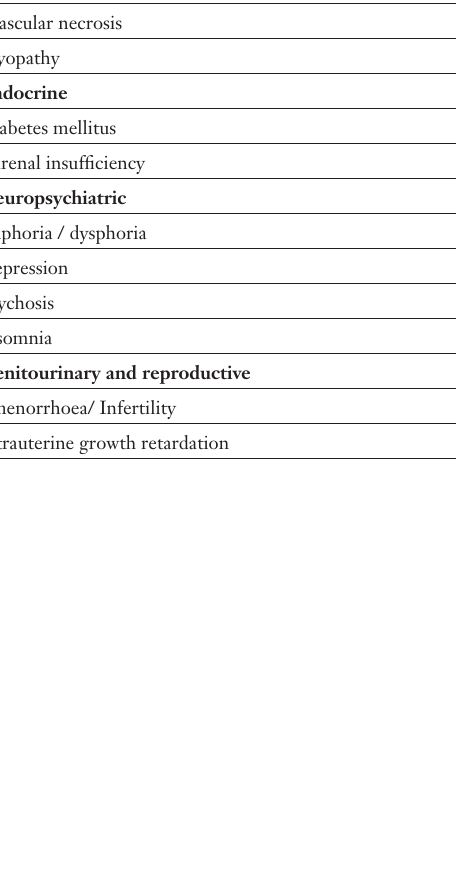
Major side effects of immunosuppressive